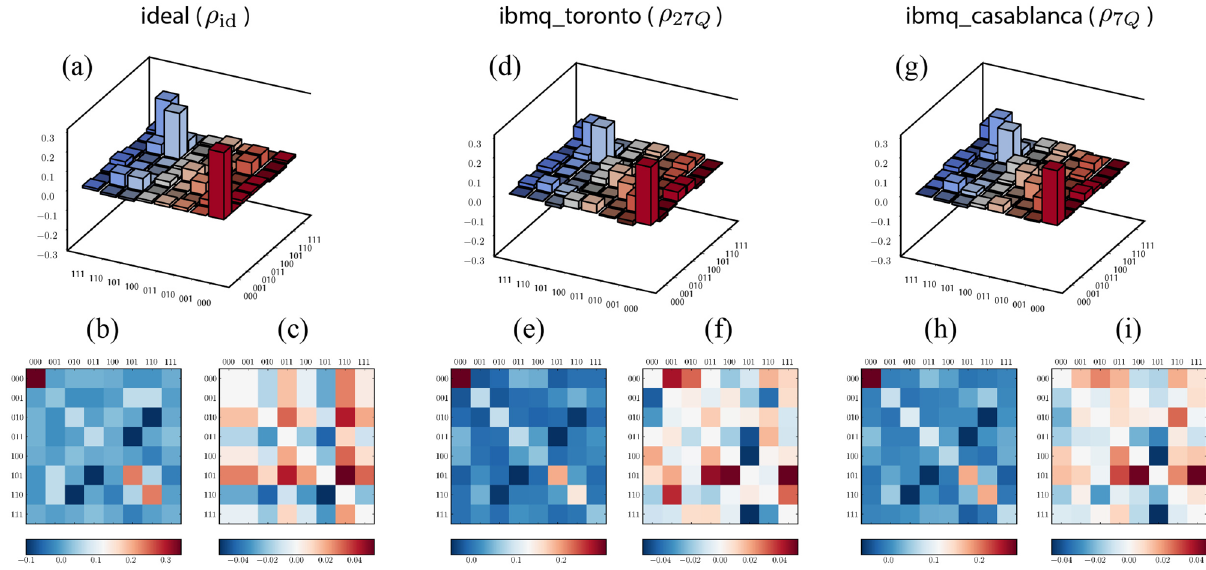
Figure 9. Ideal and measured density matrices after the inverse QFT, estimated via a maximum-likelihood reconstruction from measurement results in the Pauli-basis. (a) The ideal state shown, imaginary parts are less than 0.04). (b) A matrix plot of the real part of (cid:31) (cid:31) imaginary part of . These plots are compared with the measured states ρ 27 Q and ρ 7 Q in panels (d,g) , and | �� | the corresponding matrix plot of their real parts in panels (e,h) , and imaginary parts in panels (f,i) ,